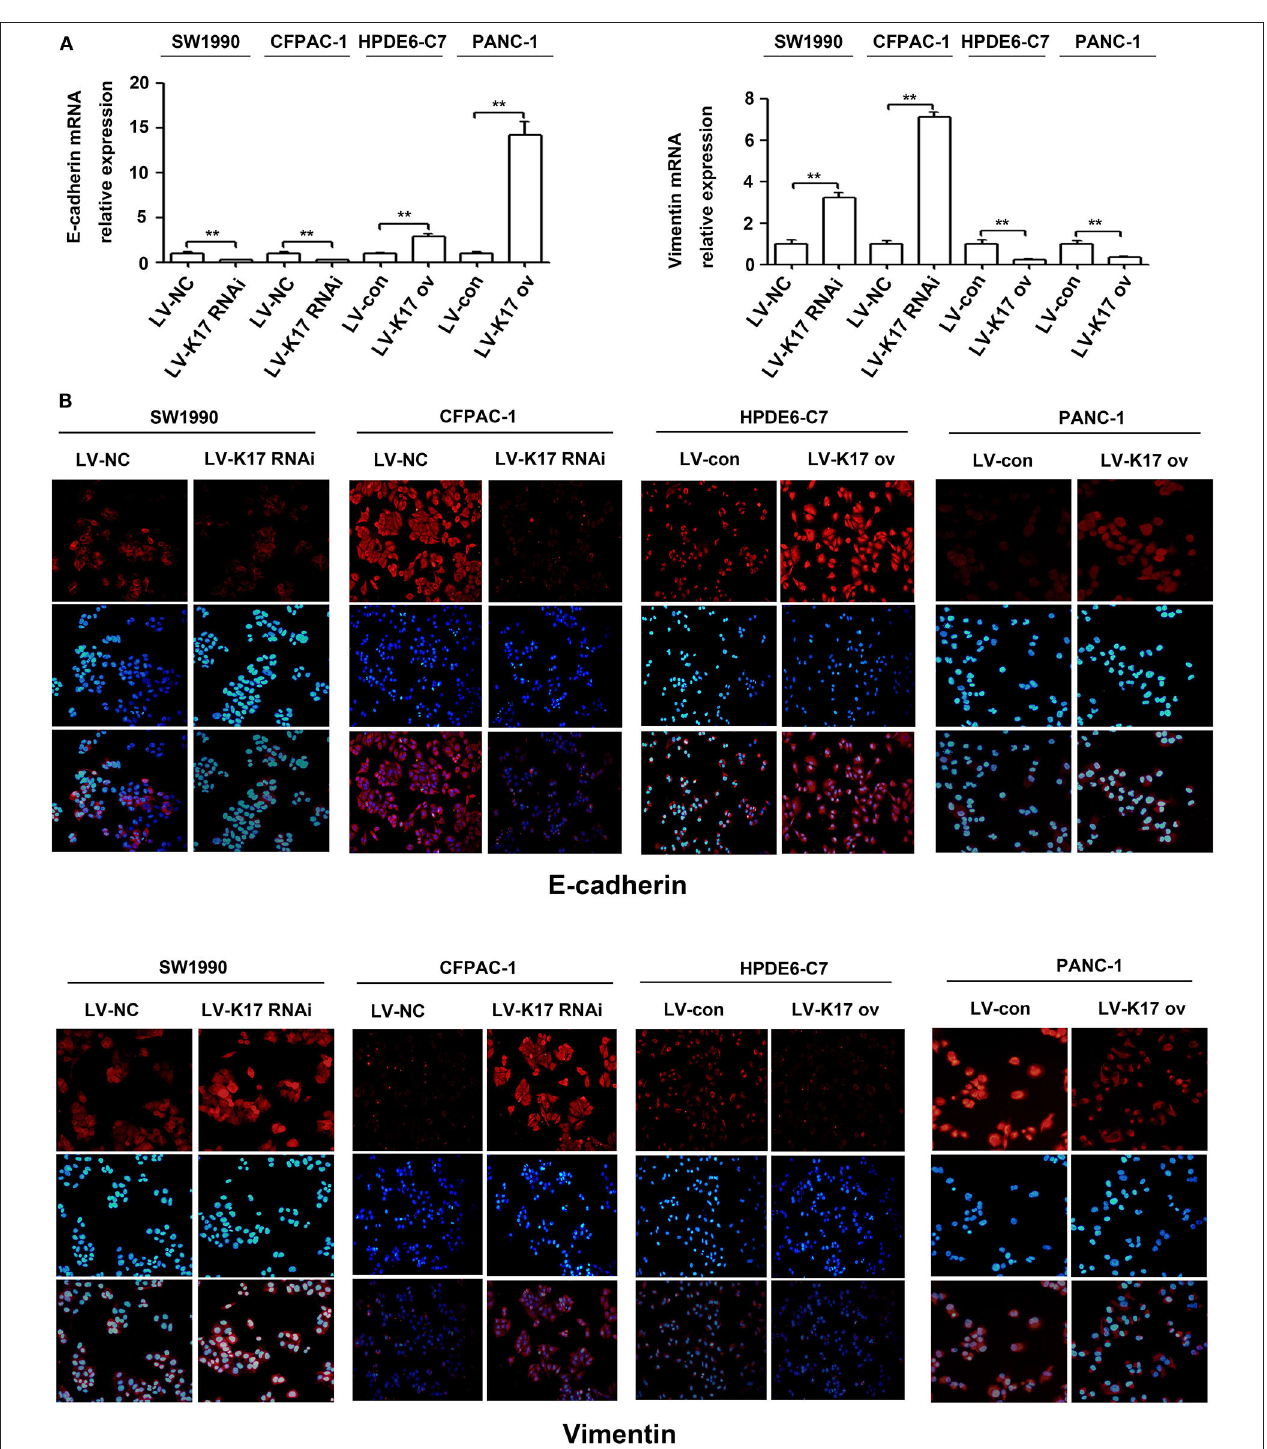
FIGURE 7 | K17 inhibited the EMT in pancreatic cancer cells. (A) qRT-PCR analysis of E-cadherin and Vimentin mRNA expression in stable K17-silenced SW1990 and CFPAC-1 cells and in stable K17 upregulated HPDE6-C7 and PANC-1 cells. (B) Immunofluorescence staining of E-cadherin and Vimentin protein expression in stable K17-silenced SW1990 and CFPAC-1 cells and in stable K17 upregulated HPDE6-C7 and PANC-1 cells. ** P < 0.01.